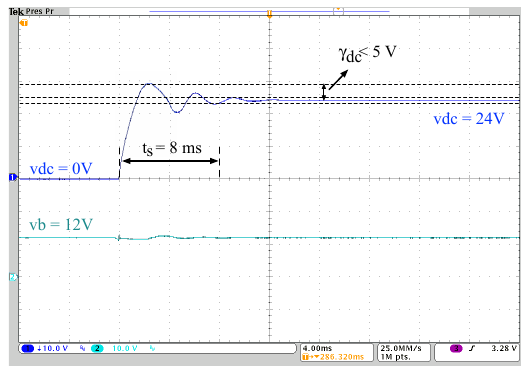
Figure 14. Experimental performance of the proposed